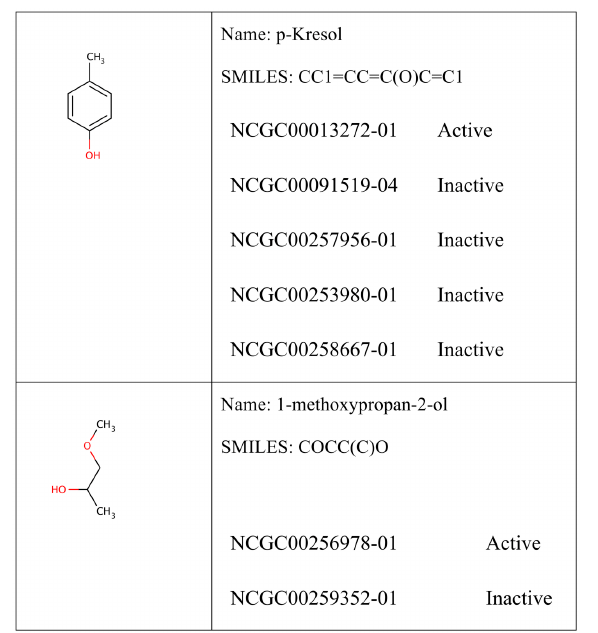
FIGURE 1 | Example of conflicting training data. The examples shown were obtained from the Estrogen Nuclear Receptor dataset. In some cases, it could be reasonable to assume that p-Kresol would be inactive (four records shows inactive against only one active record). In other cases, such as methoxypropan-2-ol, it is not possible tell whether the compound was truly activating the Estrogen nuclear receptor (with one record in every class). Compounds are compared using their calculated INCHI keys generated from the SDF representation. All 12 targets showed similar